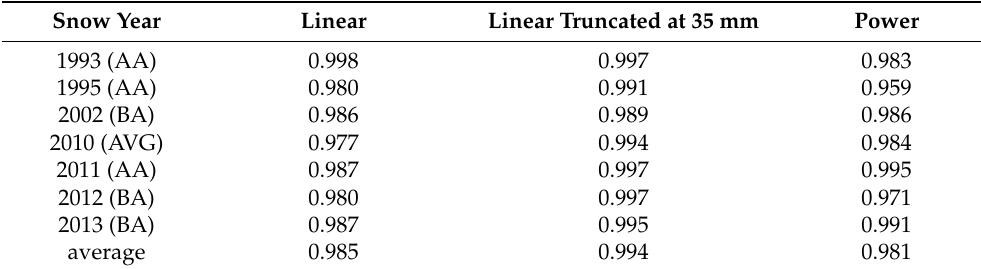
Table 1. Comparison of coefficient of determination values from three accumulation phase regression models for the seven study years (full domain) (see Figure 4). The type of snow year (Figure 2) is listed as above average (AA), average (AVG) or below average (BA).